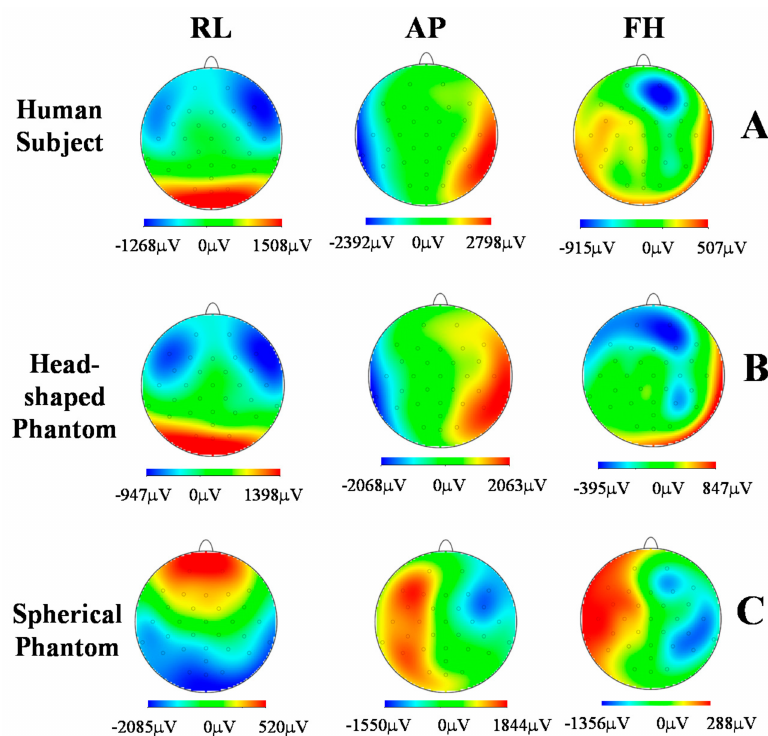
Figure 7. Spatial maps of the average root-mean-square (RMS) voltage of the induced gradient artefact (GA) in the electroencephalography (EEG) data for each orthogonal gradient (RL, AP, and FH) related to the subjects’ head ( A ), the head-shaped phantom ( B ), and the spherical phantom ( C ).